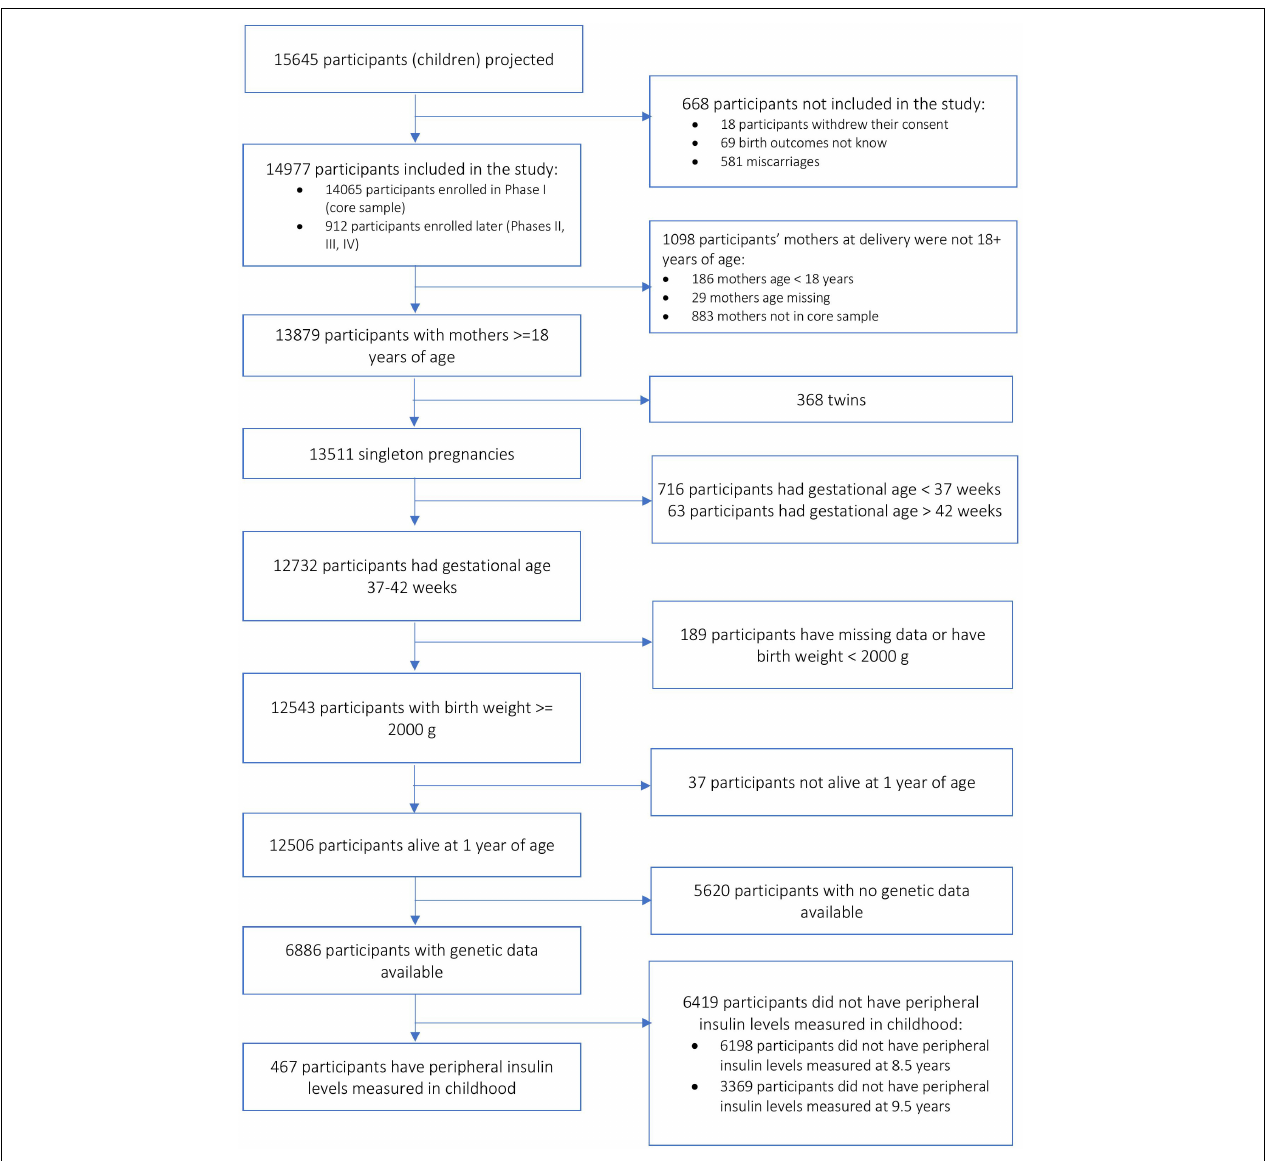
FIGURE 1 | Block scheme describing sample selection in the ALSPAC